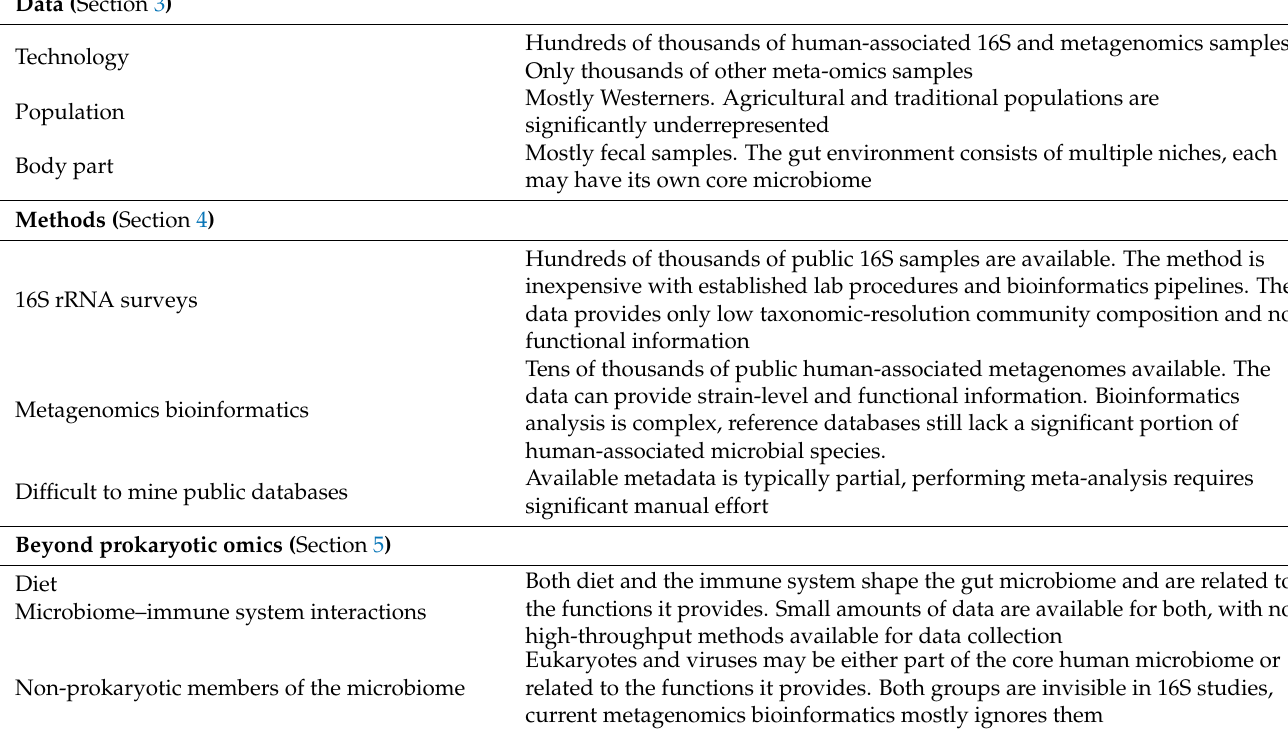
Table 2. A summary of the challenges that affect our ability to characterize the core human